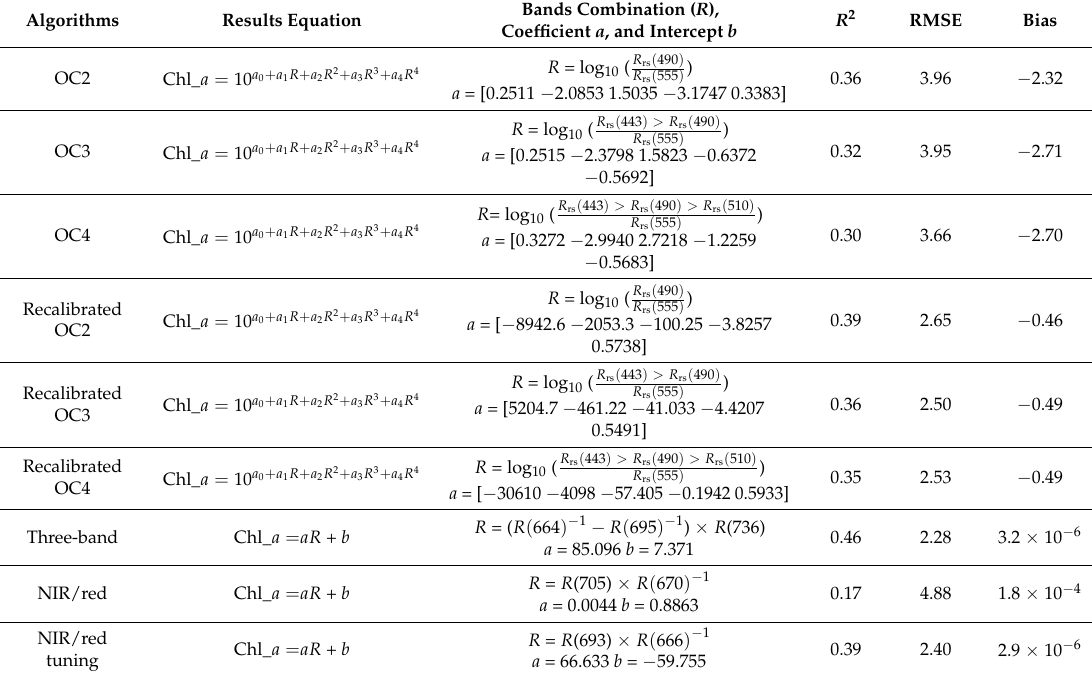
Table 3. Regression models used to estimate Chl- a concentrations.